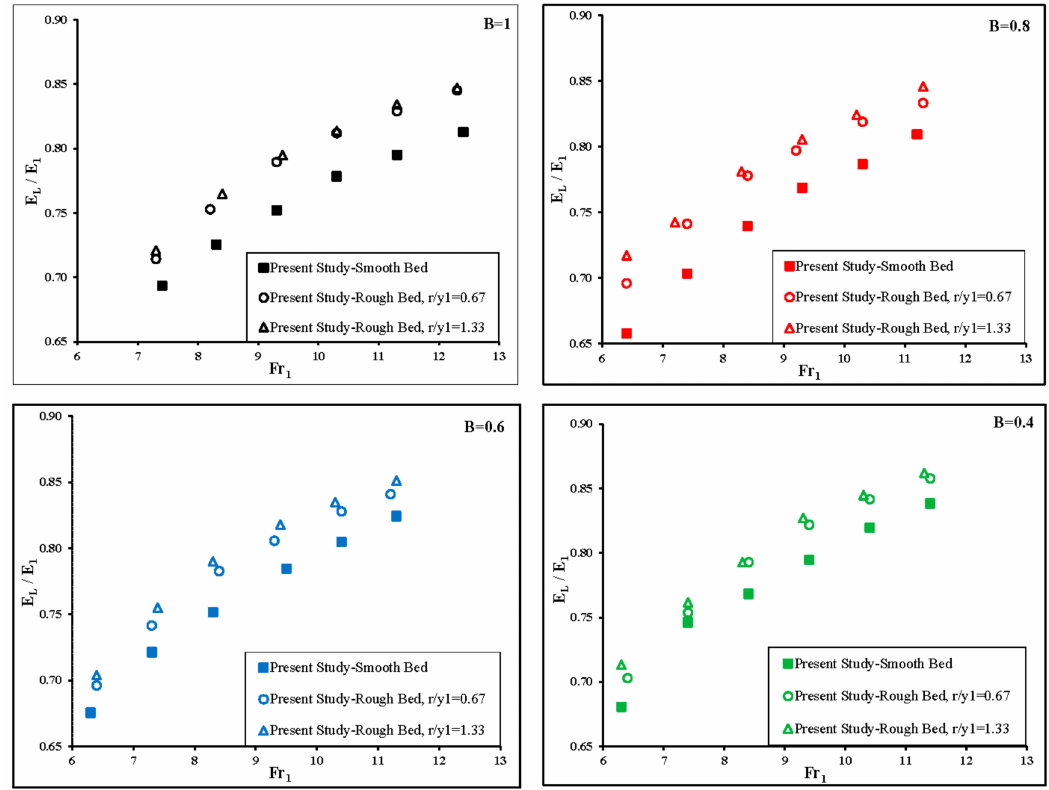
Figure 15. Variation of the relative energy loss ( E L / E 1 ) vs. the inflow Froude number for different divergence ratio ( B = 1, 0.8, 0.6 and 0.4) and two relative heights of dissipative elements ( r / y 1 = 0.67 and